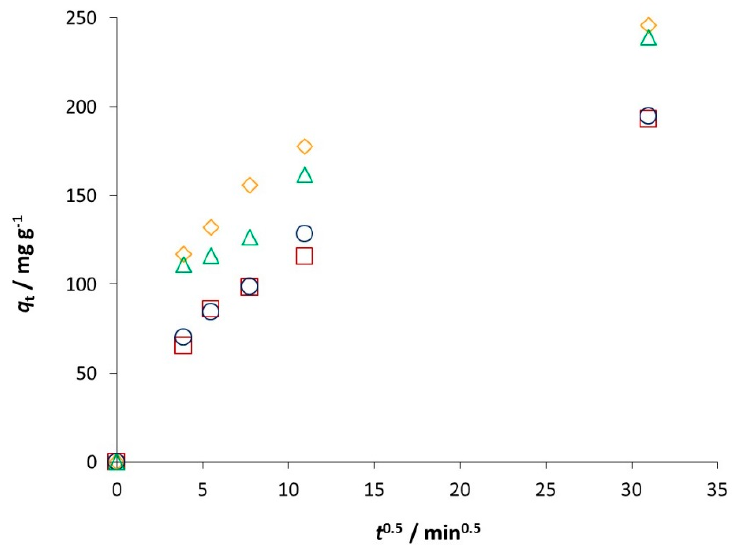
Figure 4. Root time plot for the adsorption of RB5 on activated carbon for four initial pH values ( pH 0 = 2.00; (cid:3) pH 0 = 4.00; O pH 0 = 8.00; (cid:52) pH 0 = 10.00).